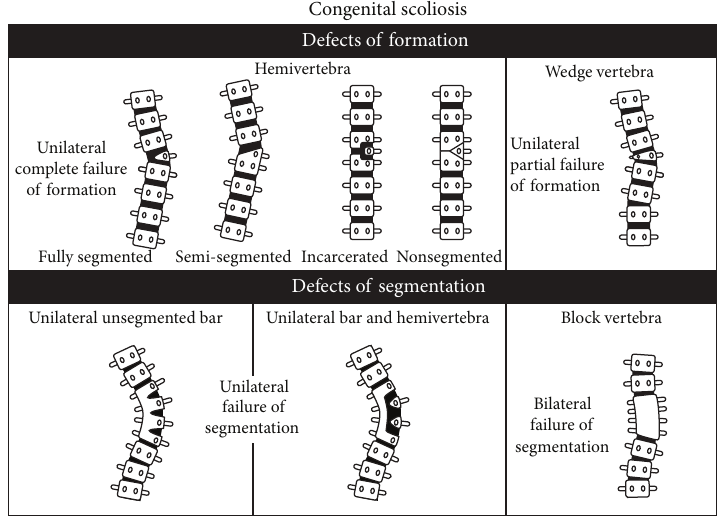
F1:Diagramofspineillustratingdefectsofformation(wedgeandhemivertebrae)andsegmentation(vertebralbarandblockvertebrae). Reprinted with permission from McMaster [6].